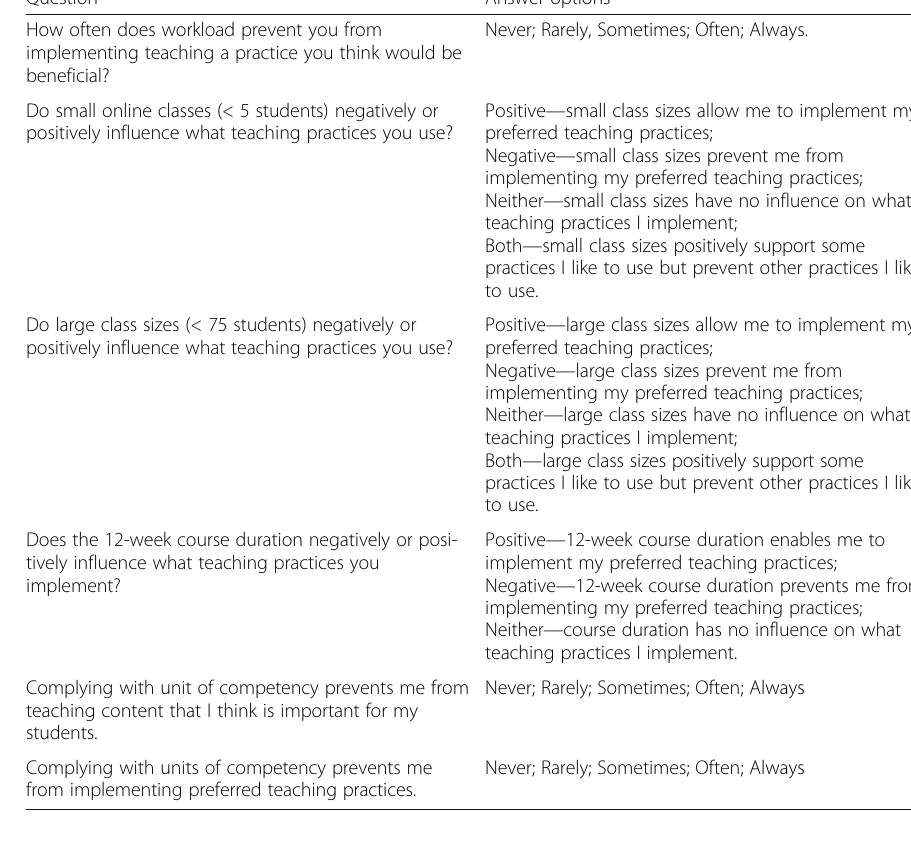
Table 12 Survey questions regarding teaching context factors that affect enacted practice Question Answer